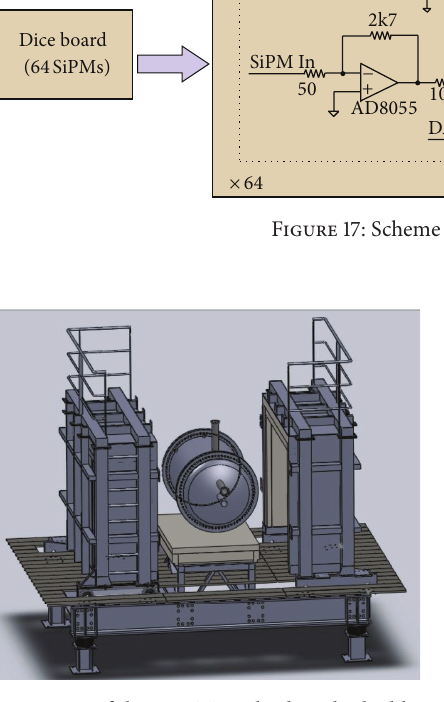
Figure 18: Drawing of the NEXT- 100 lead castle shield in its open configuration.